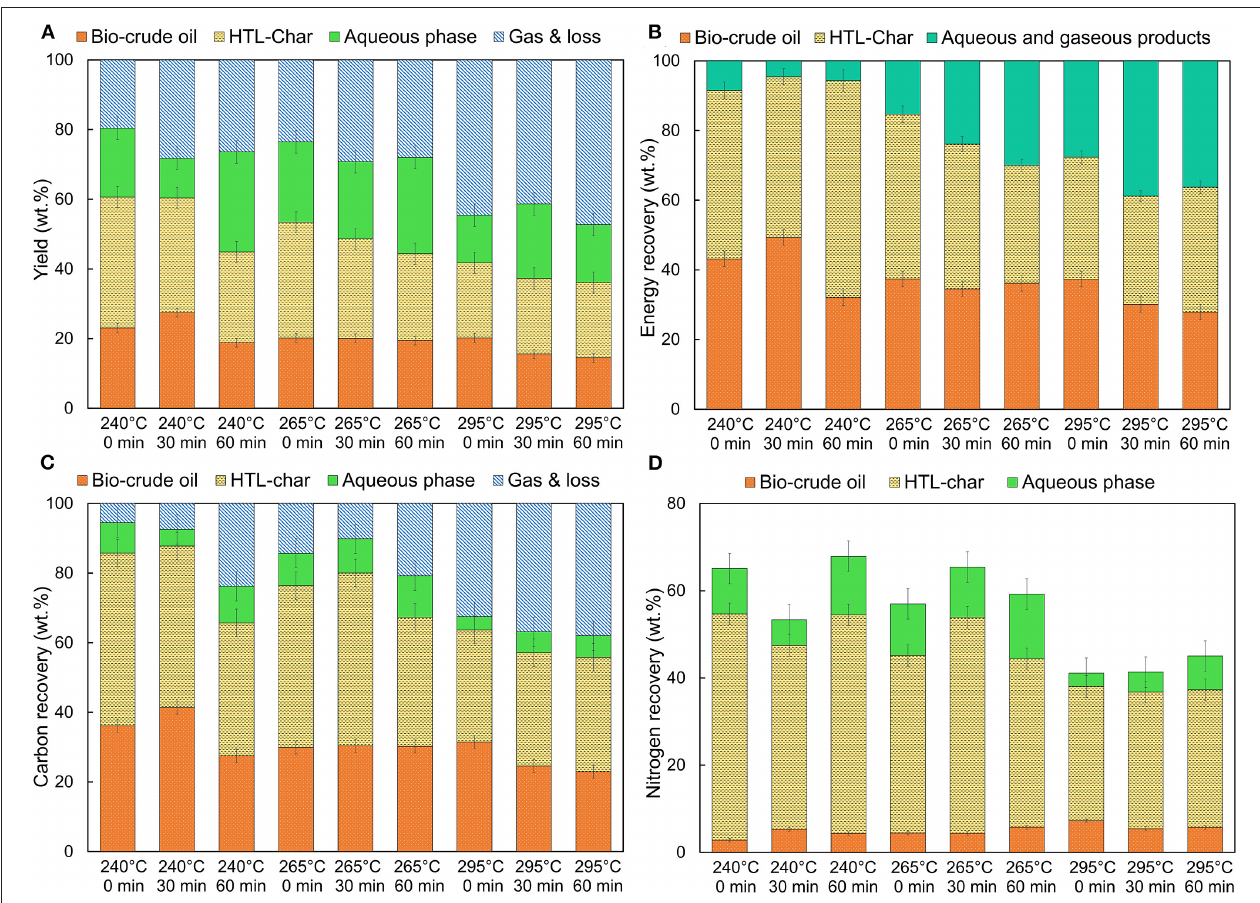
FIGURE 1 | Distribution of (A) mass, (B) energy, (C) carbon, and (D) nitrogen in wt.% dry weight basis across range of different operating conditions for HTL of food waste. Standard deviation is < ± 1.5 wt.% for (A–C) and < ± 0.5 wt.% for (D) for duplicate experiments.